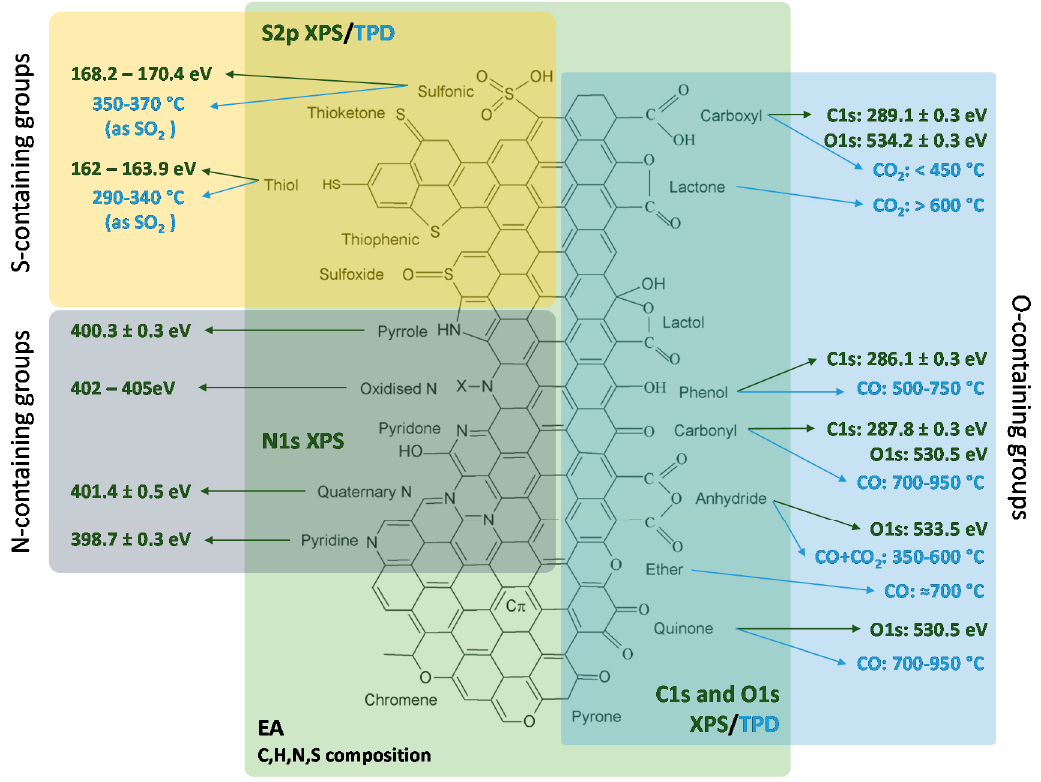
Figure 1. Oxygen, nitrogen and sulfur surface groups incorporated on carbon nanotubes (CNTs) by post-synthesis treatments, and techniques for their identification/quantification